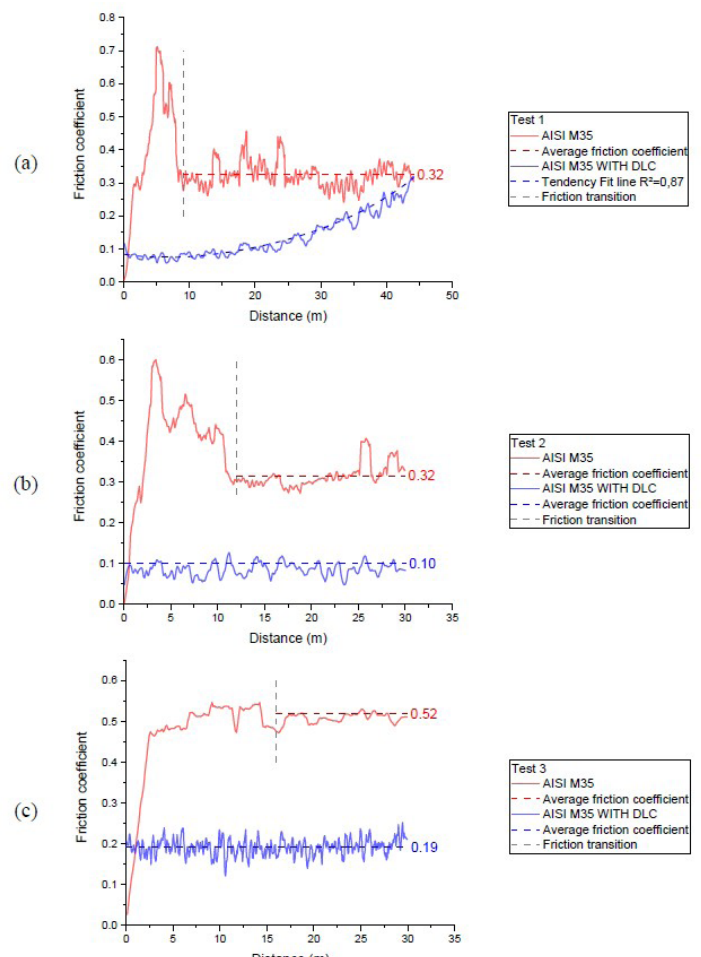
Figure 11. Curves of friction coefficient on ball-on-disc test: test 1 (a), test 2 (b) and test 3